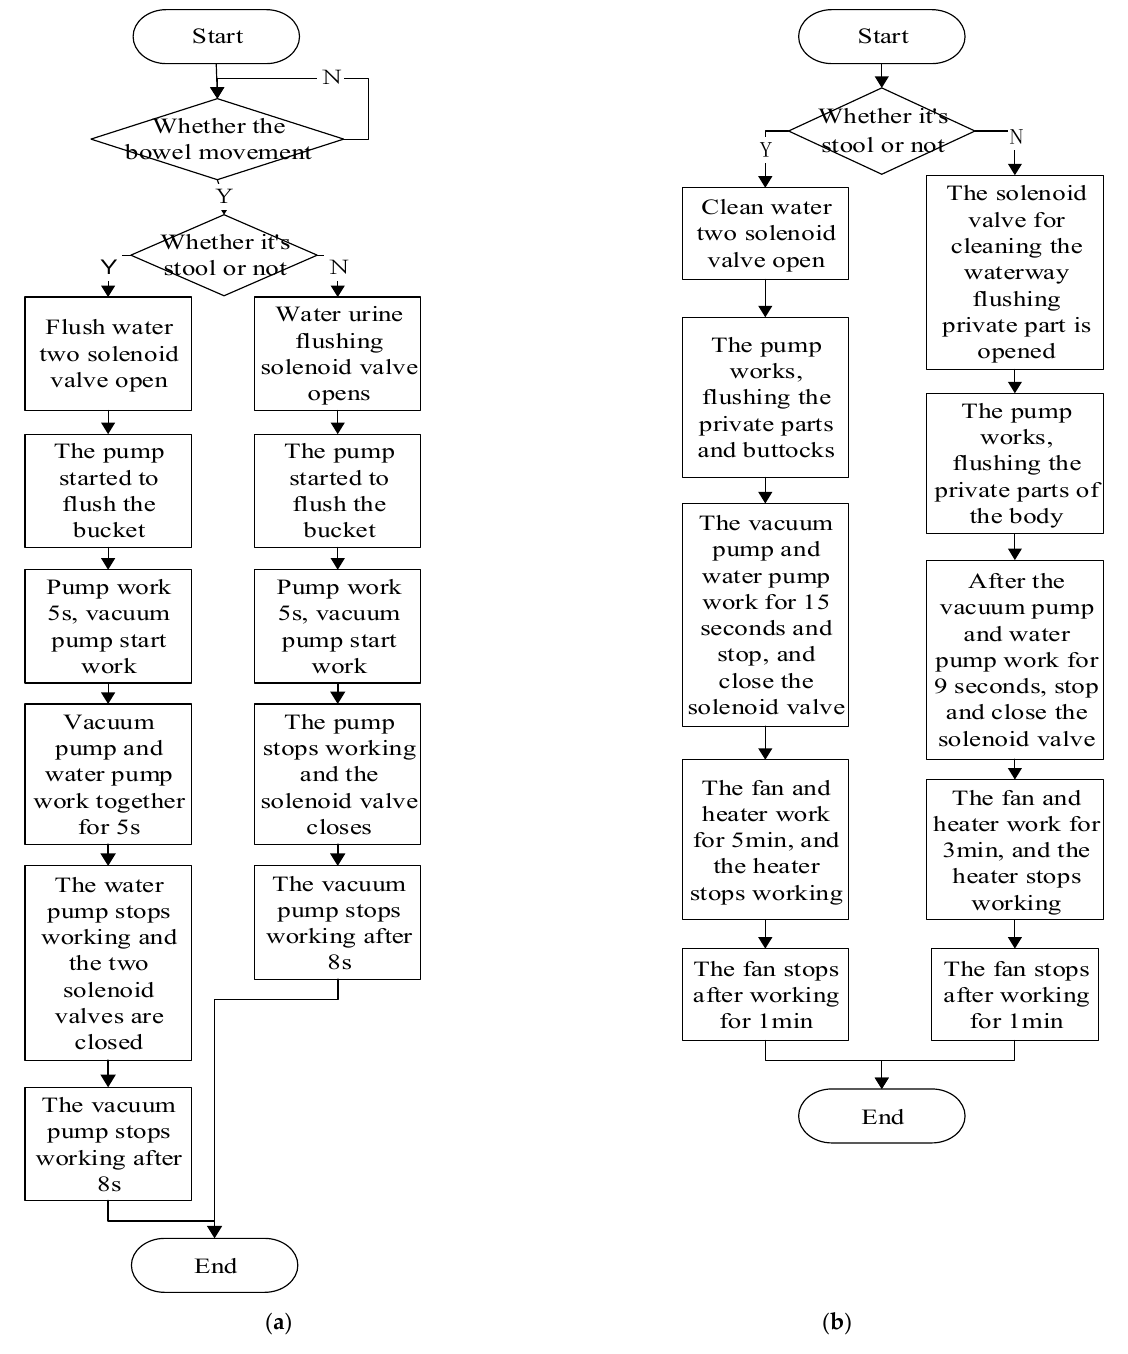
Figure 8. Flowchart of control system of excretion nursing equipment. ( a ) Test flush process; ( b ) Cleaning and drying process.